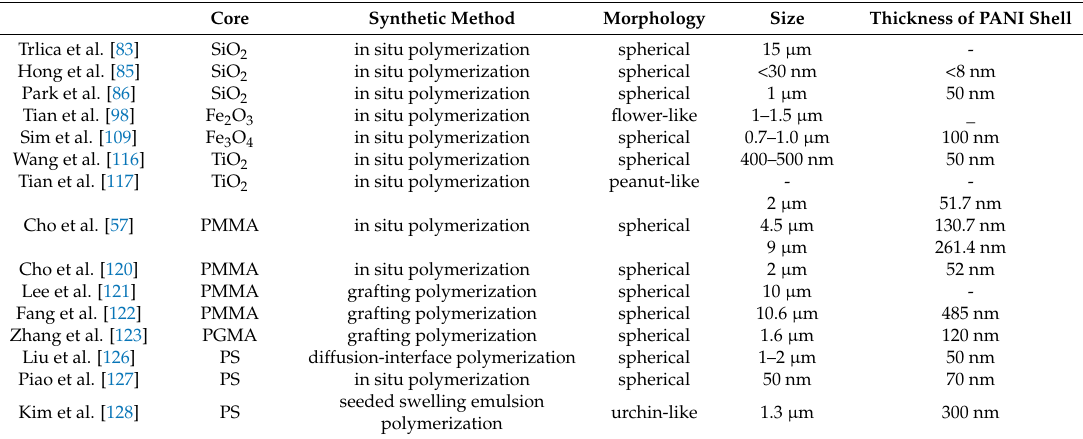
Table 3. Summary of PANI coated core-shell typed microspheres reviewed in this